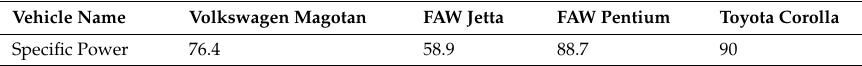
Table 3. Four models corresponding to average specific power.